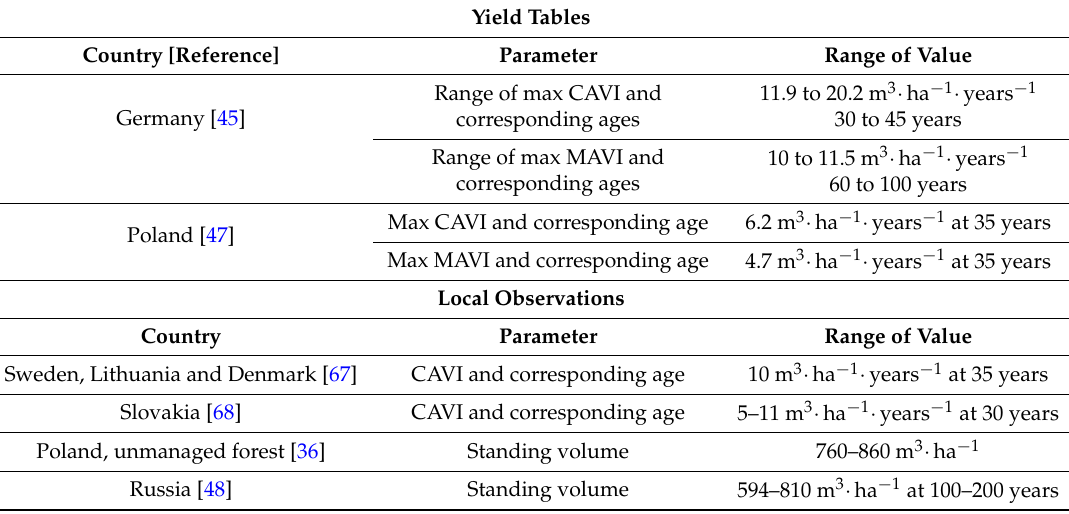
Table 1. Volume growth and productivity values for Tilia cordata in